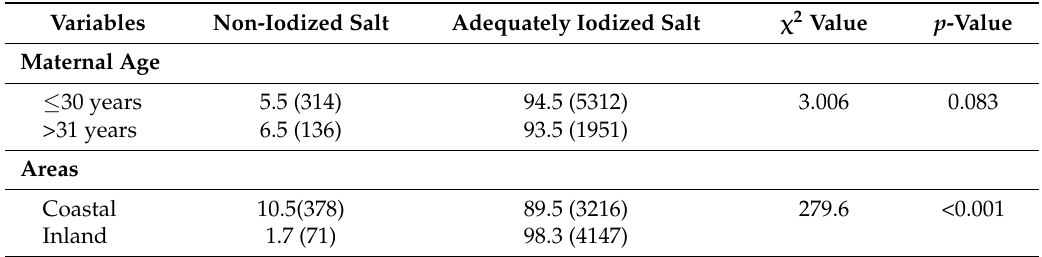
Table 4. Percentage of participants consuming salt by maternal age and areas.